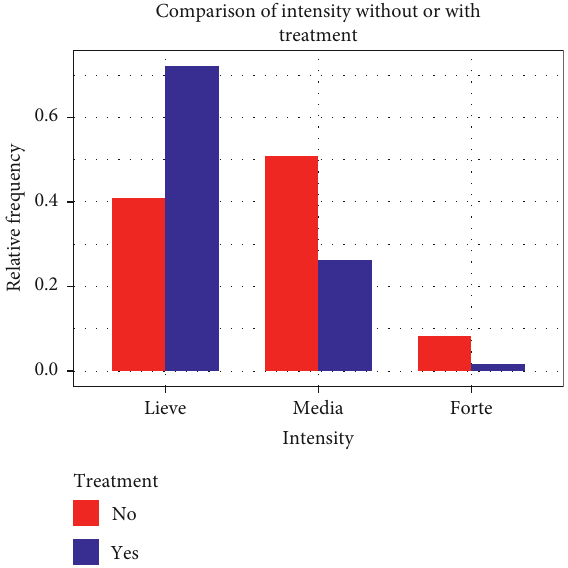
Figure 2: Result of logistic regression for correlation between age and response to